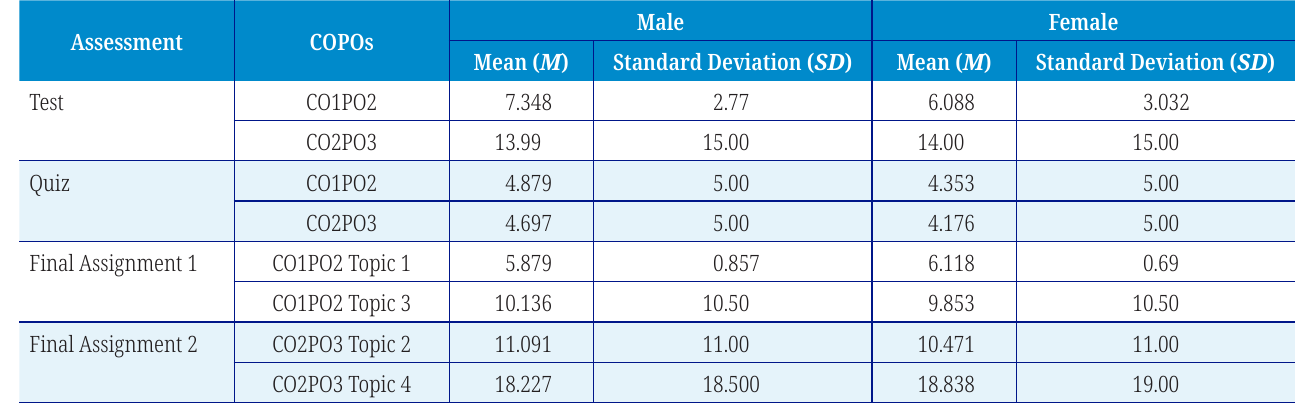
Table 3. Achievement of COPOs in course